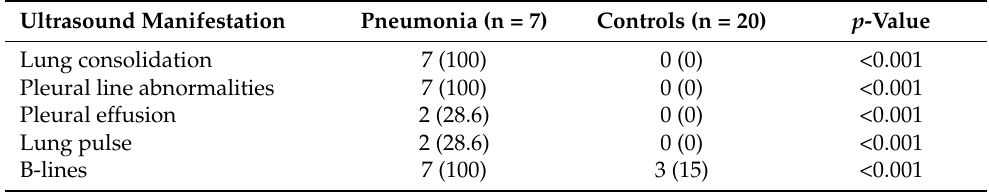
Table 1. Ultrasound manifestation in Neonatal fungal pneumonia (n,%).